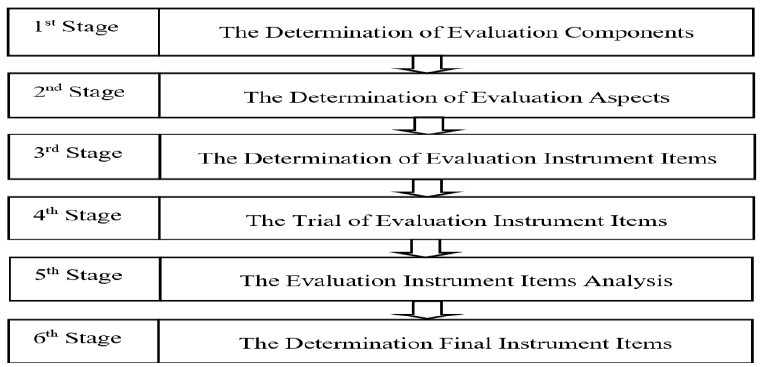
Fig. 1. Development Stage of Tri Kaya Parisudha -based Countenance Model Evaluation